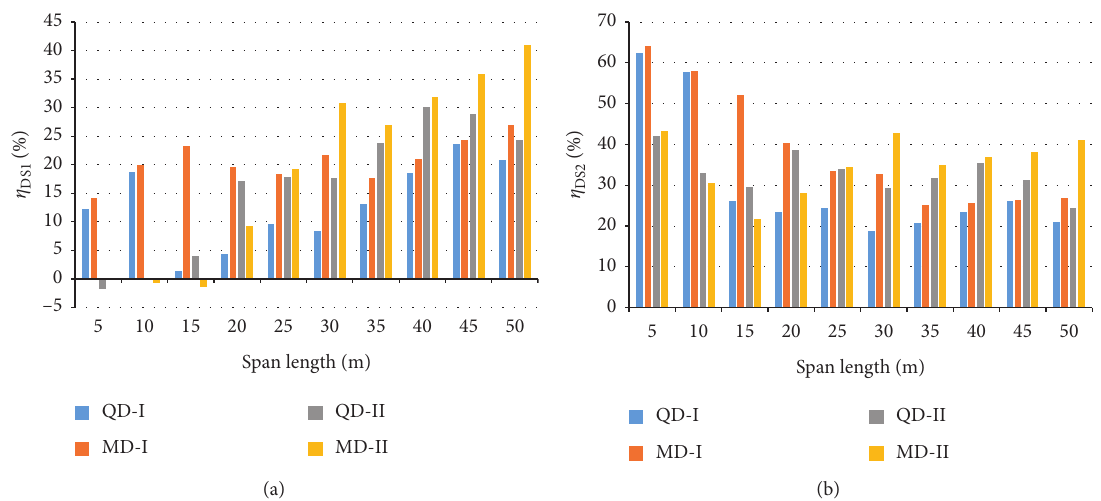
Figure 7: Comparison of the traffic loading effects with the dynamic load allowance: (a) η